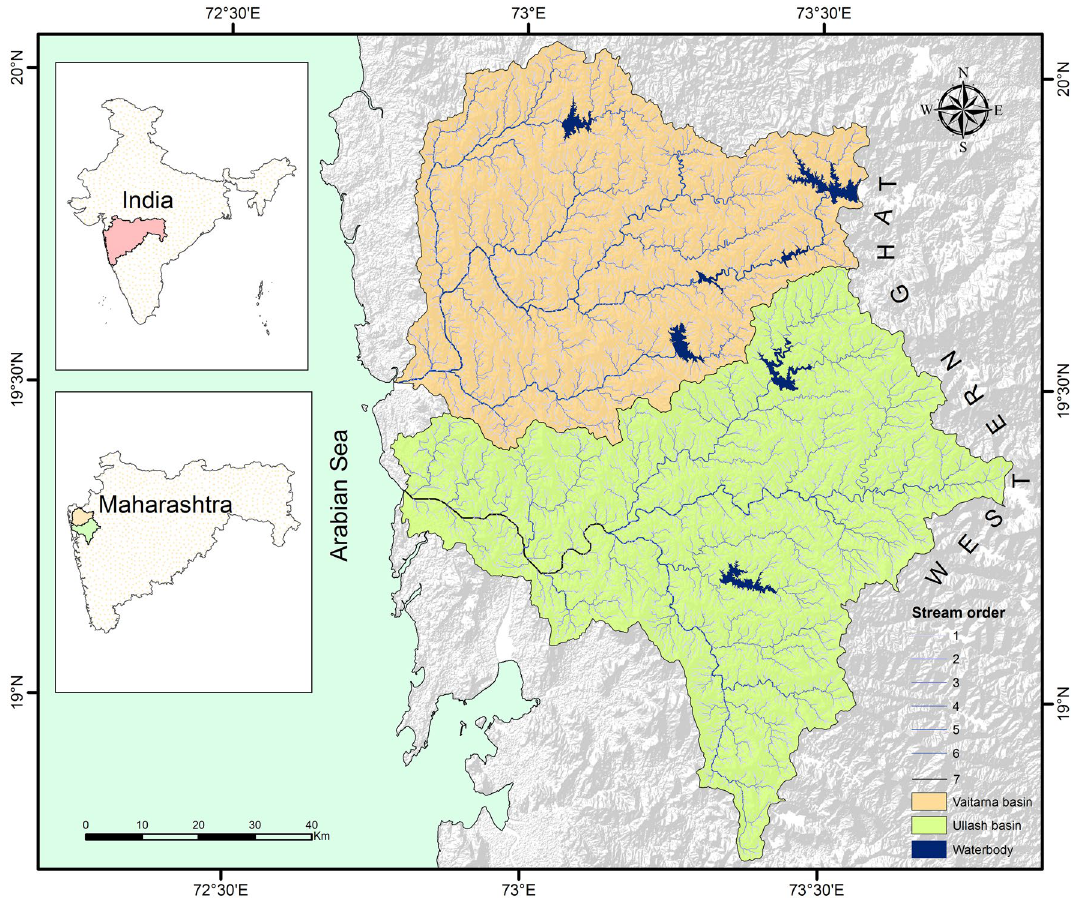
Fig. 1 Location map of the study area with respect to Maharashtra State and